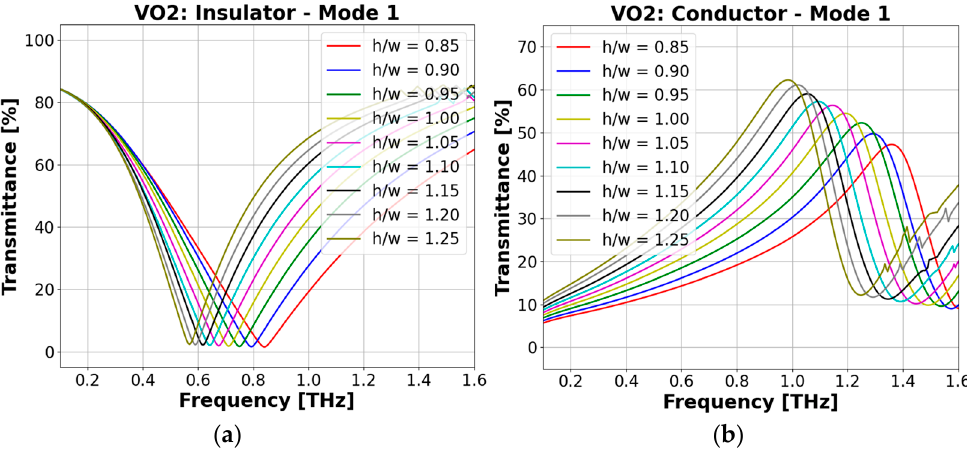
Figure 2. Transmittance of the double-split rectangular metamaterial in mode 1 with the electric field polarization parallel to the VO 2 thin film line according to the aspect ratio. ( a ) VO 2 in the insulator state and ( b ) VO 2 in the conductor state.